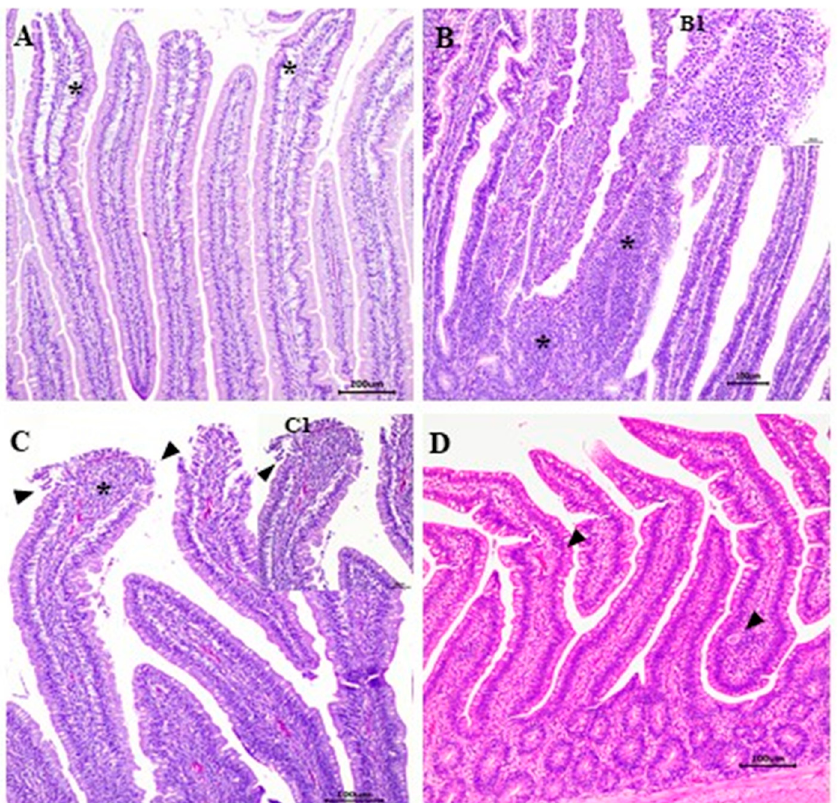
Figure 3. Changes observed in the microscopic score. ( A ) Duodenum, G6 (CP14 + IBDV-vac), interstitial edema (*), bar 100 µm, HE. ( B ) Jejunum, G11 ( Eimeria spp.), moderate presence of inflammatory infiltrate (*), bar 100 µL, HE. ( B1 ) Insert—inflammatory infiltrate, bar 50 µm, HE. ( C ) Duodenum, G11 ( Eimeria spp.) villus apical necrosis, moderate presence of inflammatory infiltrate (*) bar 100 µL, HE. ( C1 ) Insert—villus apical necrosis ( ▼ ) bar 50 µm, HE. ( D ) Jejunum, G2 (CP13 + Eimeria spp.), Eimeria spp. ( ▼ ), bar 100 µL, HE.